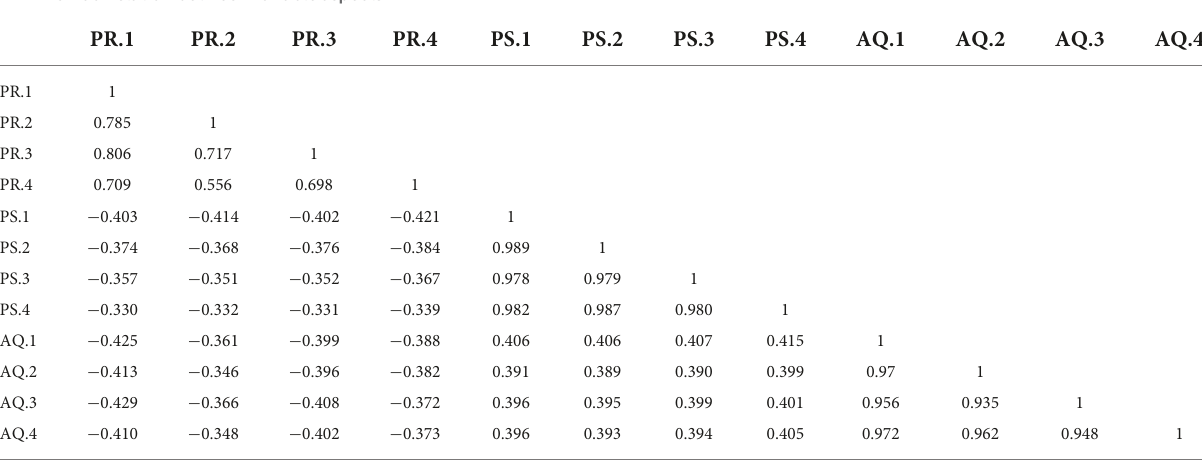
TABLE 5 Correlation between variable